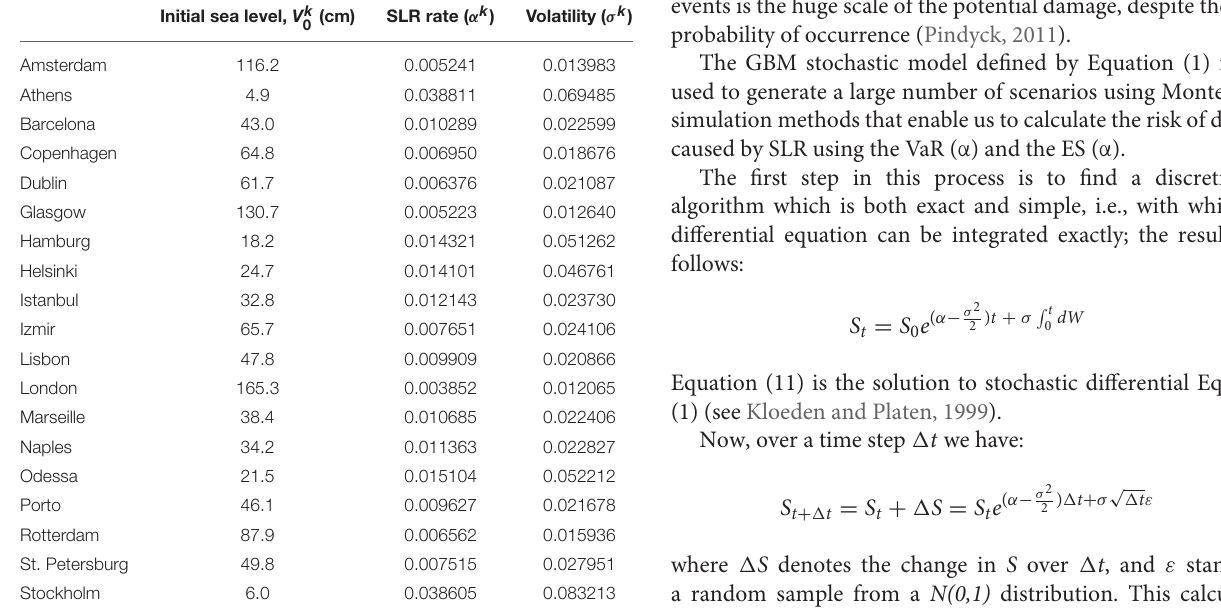
TABLE 2 | Estimated values obtained for the different parameters in the calibration process. City